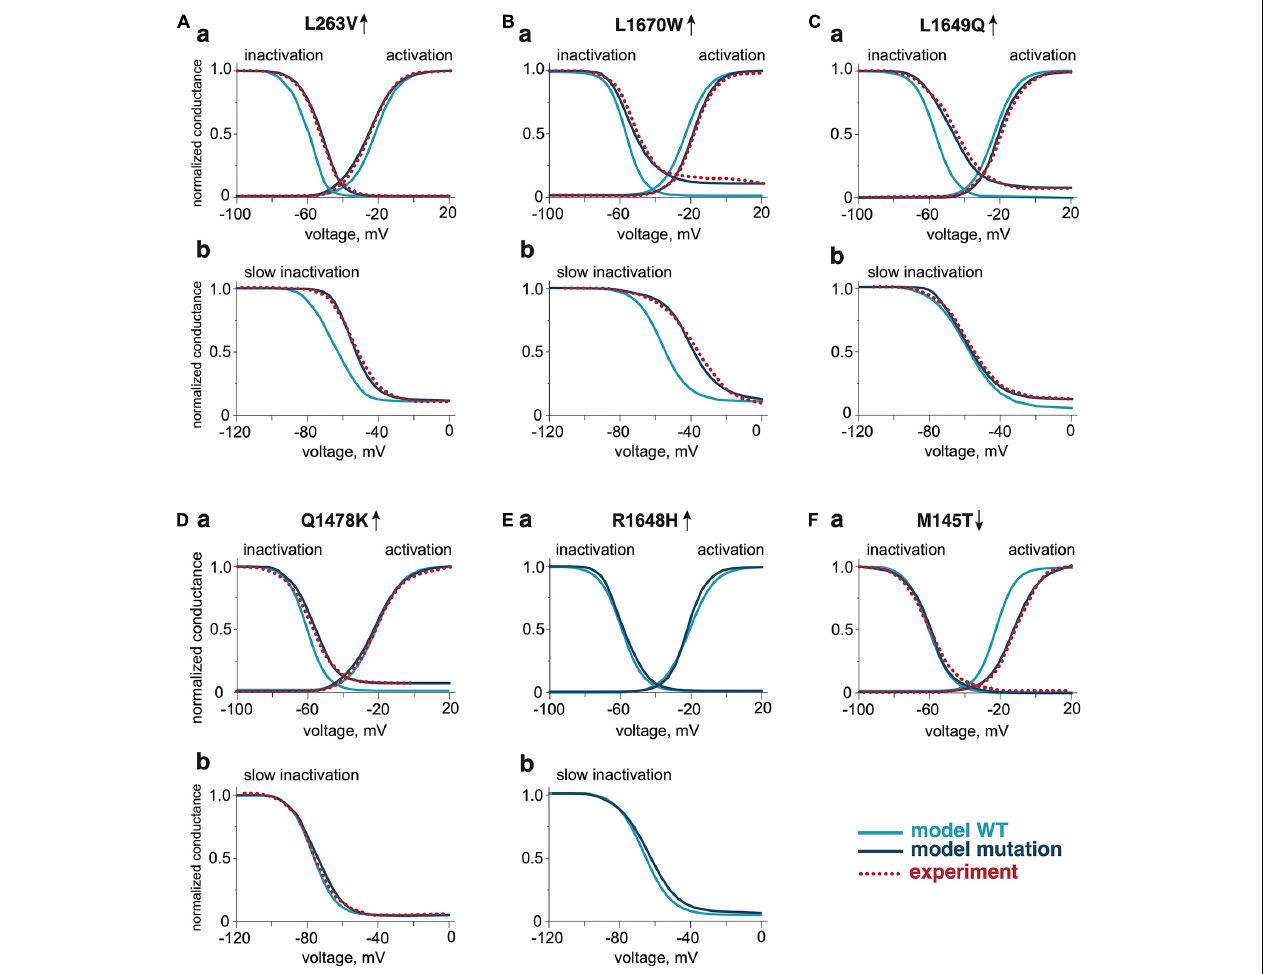
FIGURE 2 | The activation and inactivation properties of WT and Na V 1.1 mutants. The comparison of voltage dependence of activation and fast inactivation of Na V 1.1 WT and mutants L263V (Aa) , L1670W (Ba) , L1649Q (Ca) , Q1478K (Da) , R1648H (Ea) , and M145T (Fa) . The comparison of voltage dependence of slow inactivation development of Na V 1.1 WT and gain-of-function mutants L263V (Ab) , L1670W (Bb) , L1649Q (Cb) , Q1478K (Db) , and R1648H (Eb) . The dotted line shows experimental results from Kahlig et al. (2008) for the L263V mutation, Dhifallah et al. (2018) for the L1670W mutation, Cestele et al. (2008) for the L1649Q mutation, Cestele et al. (2013) for the Q1478K mutation, and Mantegazza et al. (2005) for the M145T mutation. Mutations were compared with the respective WT data from the publication that presented experimental data for the mutations.